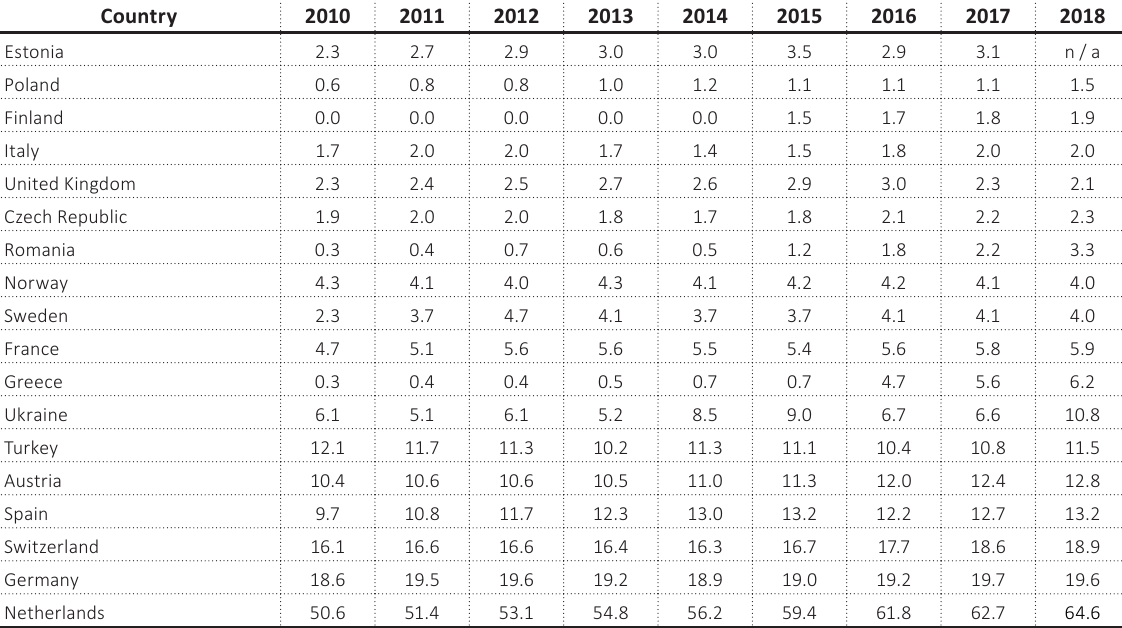
Table A4. The share of health insurance in gross insurance premiums,